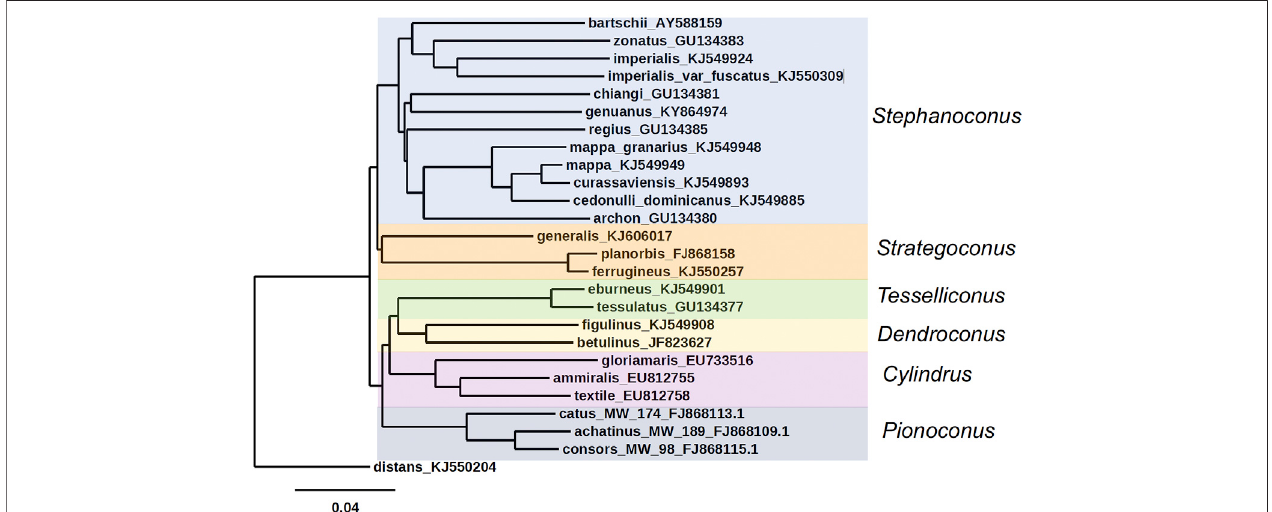
FIGURE 2 | Phylogenetic tree of Stephanoconus , Strategoconus , Dendroconu s, Tesselliconus (vermivorous), Cylindrus (molluscivorous), and Pionoconu s (piscivorous) clades of Conus species, using mitochondrial cytochrome oxidase C (COI) marker. Conus distans used as outgroup. Genbank accession numbers KJ549885, KJ549949, KJ549924, KJ549948, KJ549893, KJ549901, KJ5499908, KJ550257, KJ550309, and KJ550204 (Puillandre et al., 2014); GU134380, GU134381,GU134383,andGU134385(Watkinsetal.,2010);AY588159(DudaandRolan,2005);KY864974(Abaldeetal.,2019);FJ868158(Biggsetal.,2010); KJ606017 (Aman et al., 2015); FJ868109, FJ868113, and FJ868115 (Kantor and Taylor, 2000; Puillandre et al., 2010); EU733516, EU812755, EU812758, and GU134377 (Nam et al., 2009); JF823627 (Cabang et al., 2011; Olivera et al.,